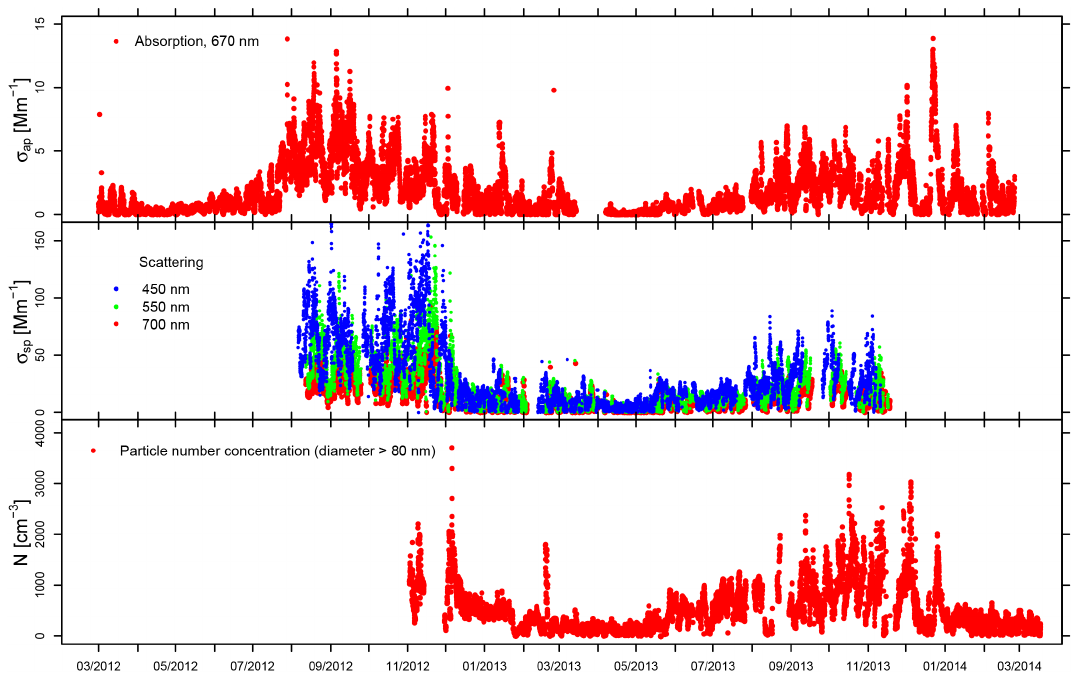
Figure 25. Time series of scattering and absorption coefficients and particle number concentration (diameter >